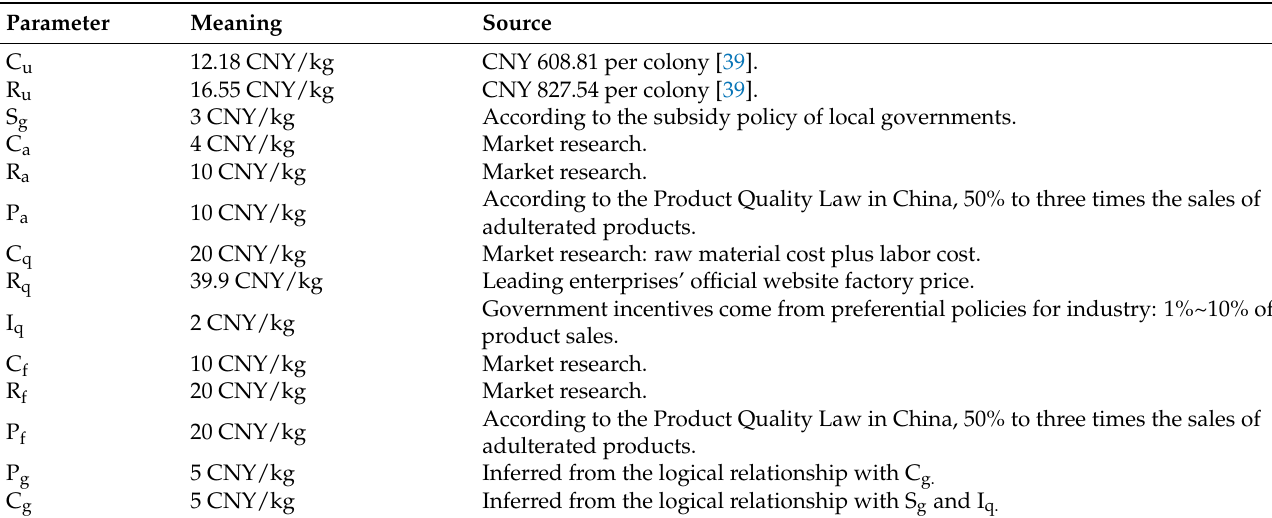
Table 3. The initial assignment for each parameter.